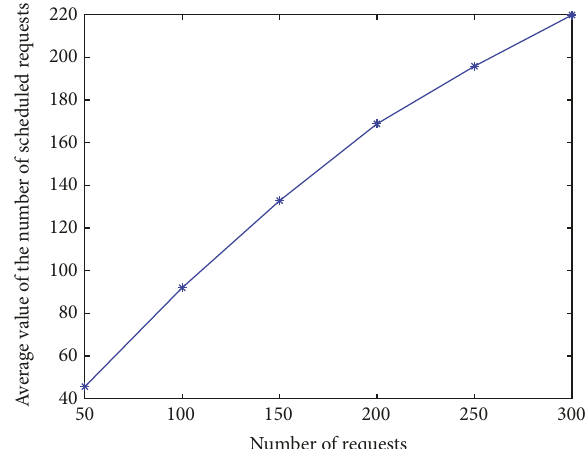
Figure 6: The average values of |𝑅 𝑠 | in HGA for different groups of